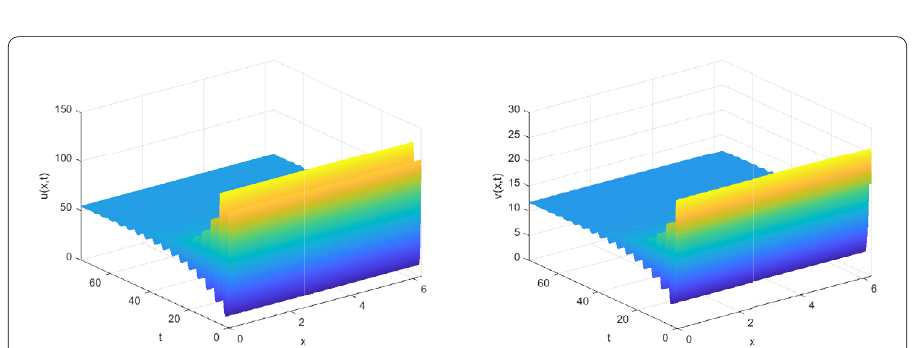
Figure 5 τ = 0.15 < τ 0 0 and the initial condition is (117.47,18.78). P ∗ = ( u ∗ , v ∗ ) is locally asymptotically stable